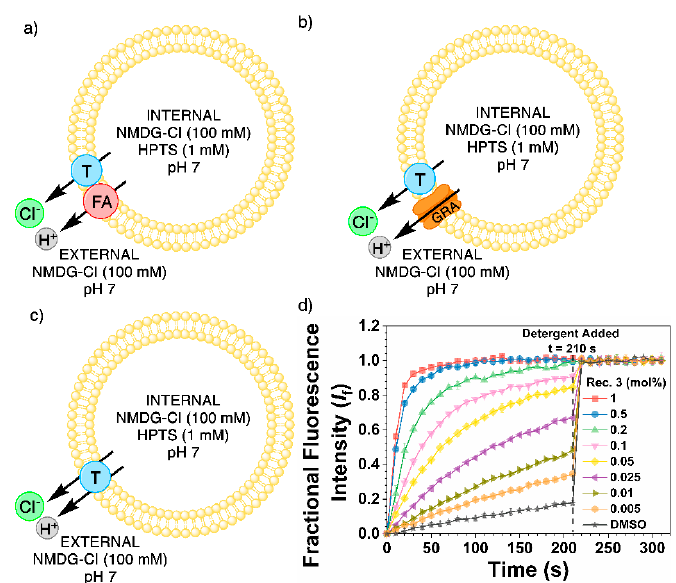
Figure 6. The three different tests utilized during the N -methyl- D -glucamine salt chloride